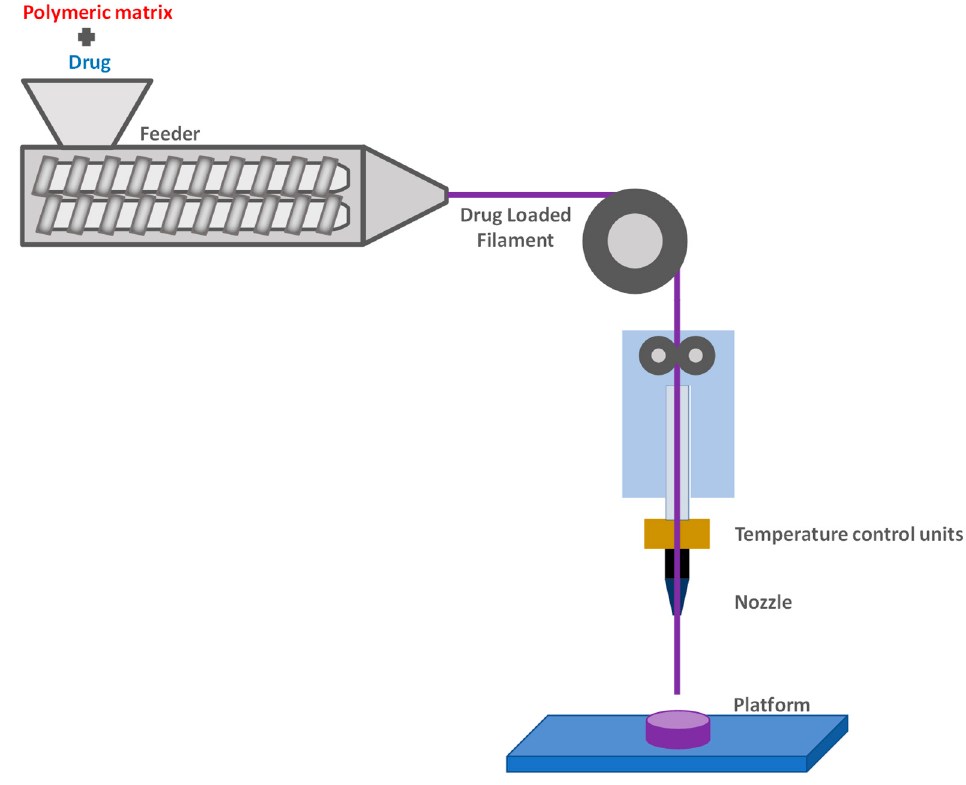
Figure 3. Simplified scheme illustrating the operating principle of hot-melt extrusion combined with fused deposition modeling. fused deposition